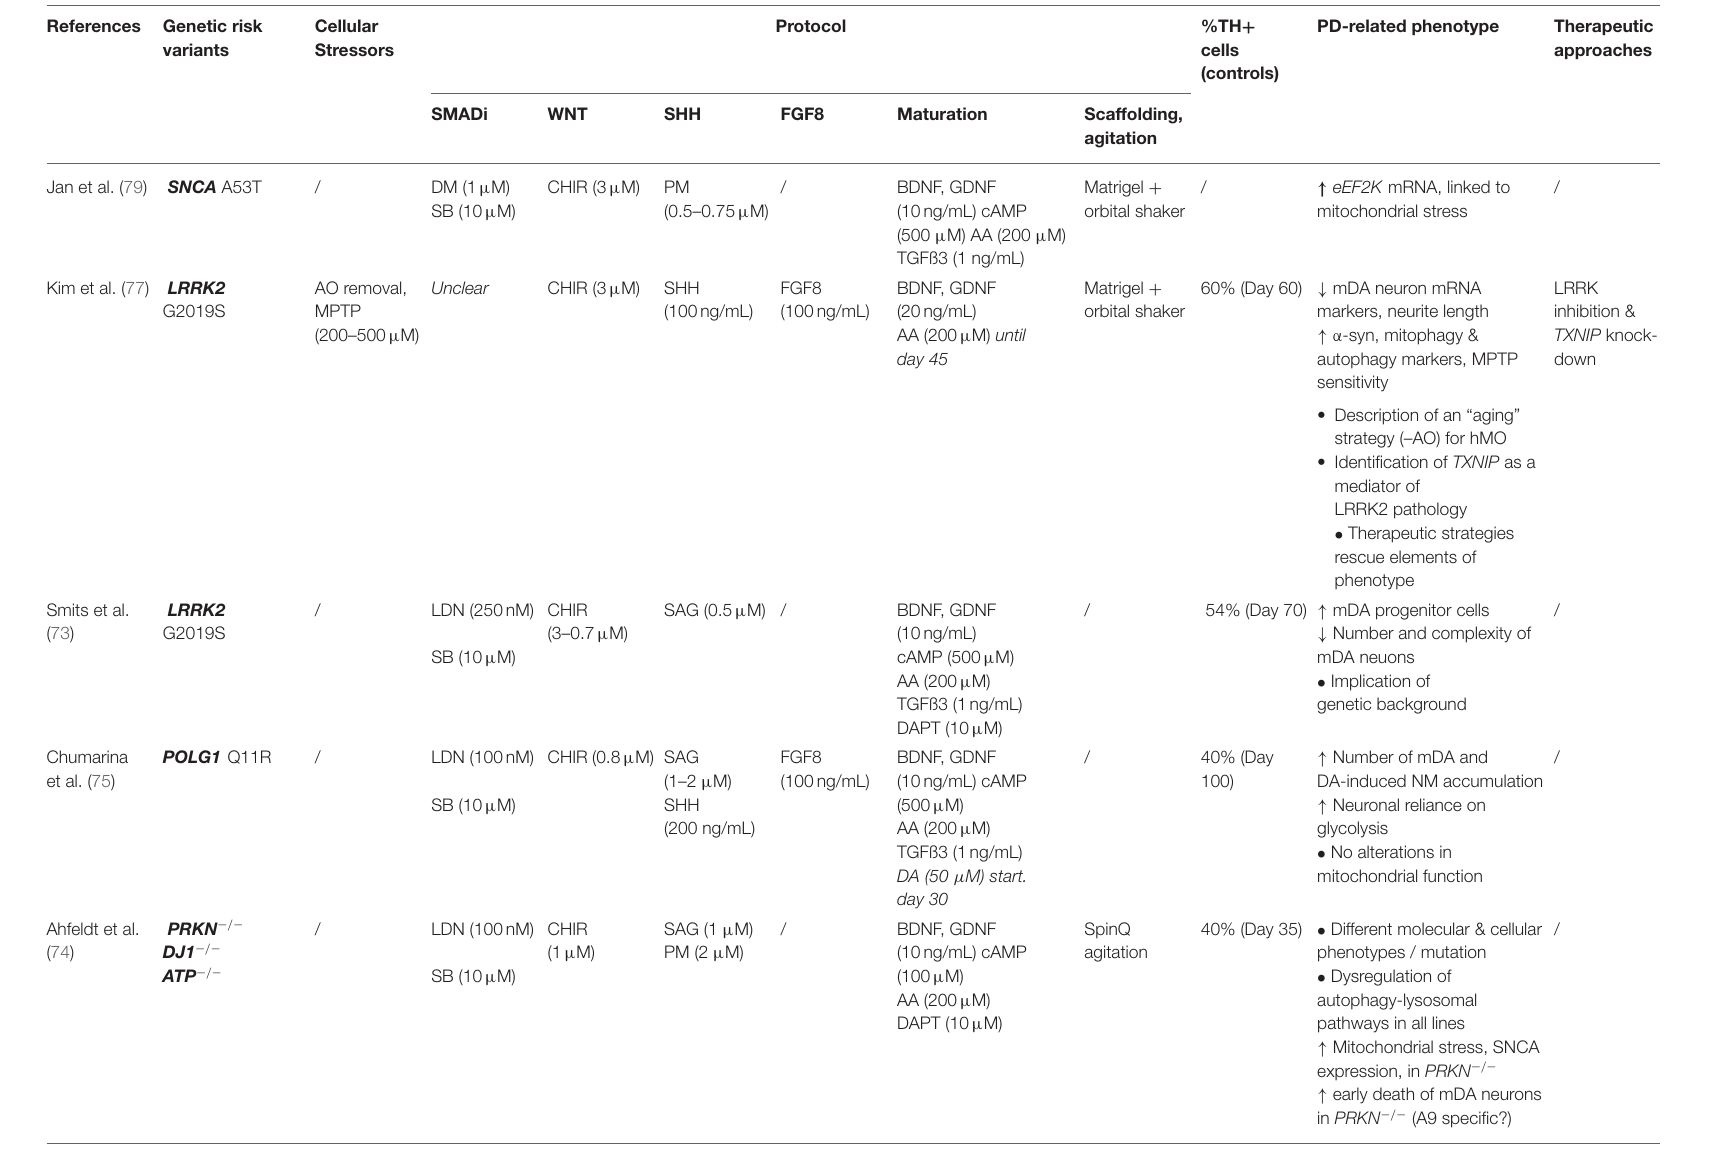
TABLE 1 | Summary of studies using hMO to model